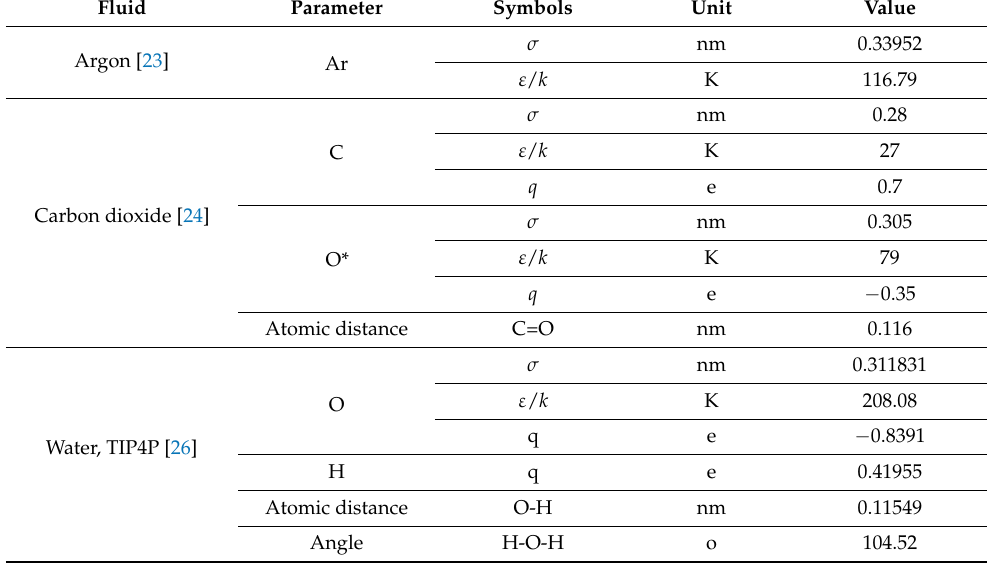
Table 1. Force field parameters of the probe